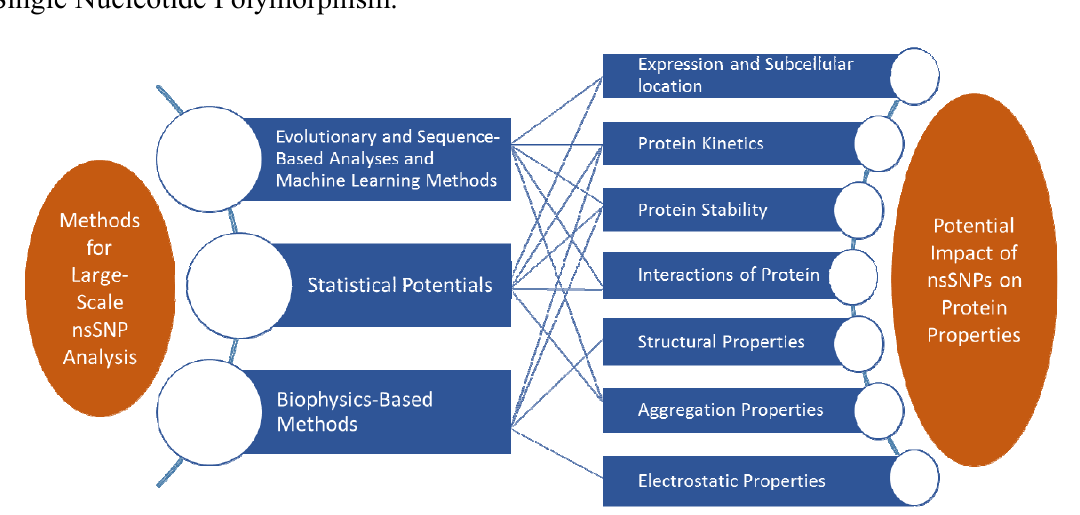
Figure 1. Flowchart illustrating the methods ( left ) used for assessment of potential impacts ( right ) of DNA mutations on protein properties and interactions. nsSNP, non-synonymous Single Nucleotide